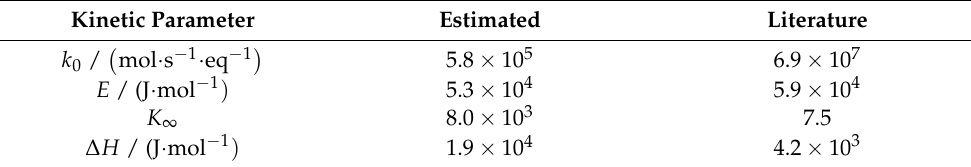
Table 4. Kinetic parameters for heterogeneous and pseudo-homogeneous.